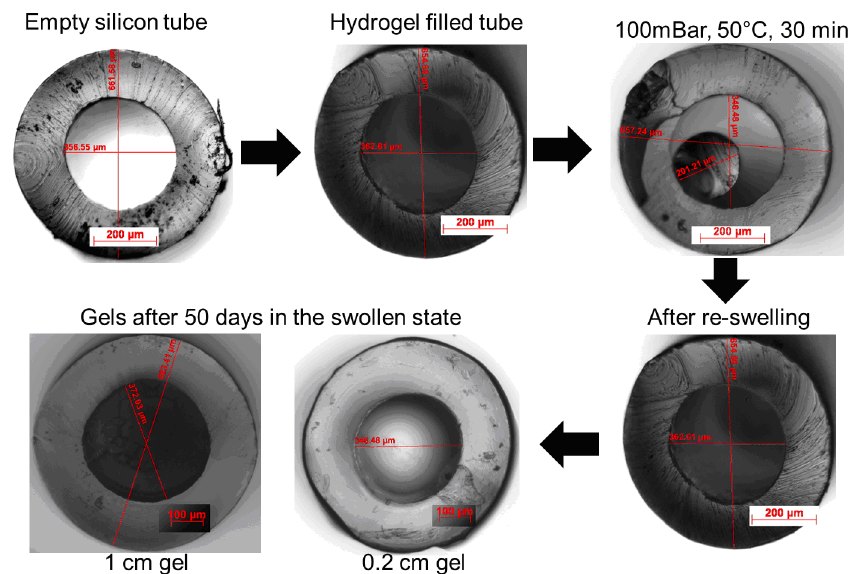
Figure 2. Cross-section images of silicone tubes before and after filling between 2 and 10 mm with with 20% (w/v) NCO-sP(EO-stat- PO) gels (top left and middle), after drying of the gel (top right), re-swelling (bottom right) and after maintaining the gels in a swollen condition for 50 days (bottom left).